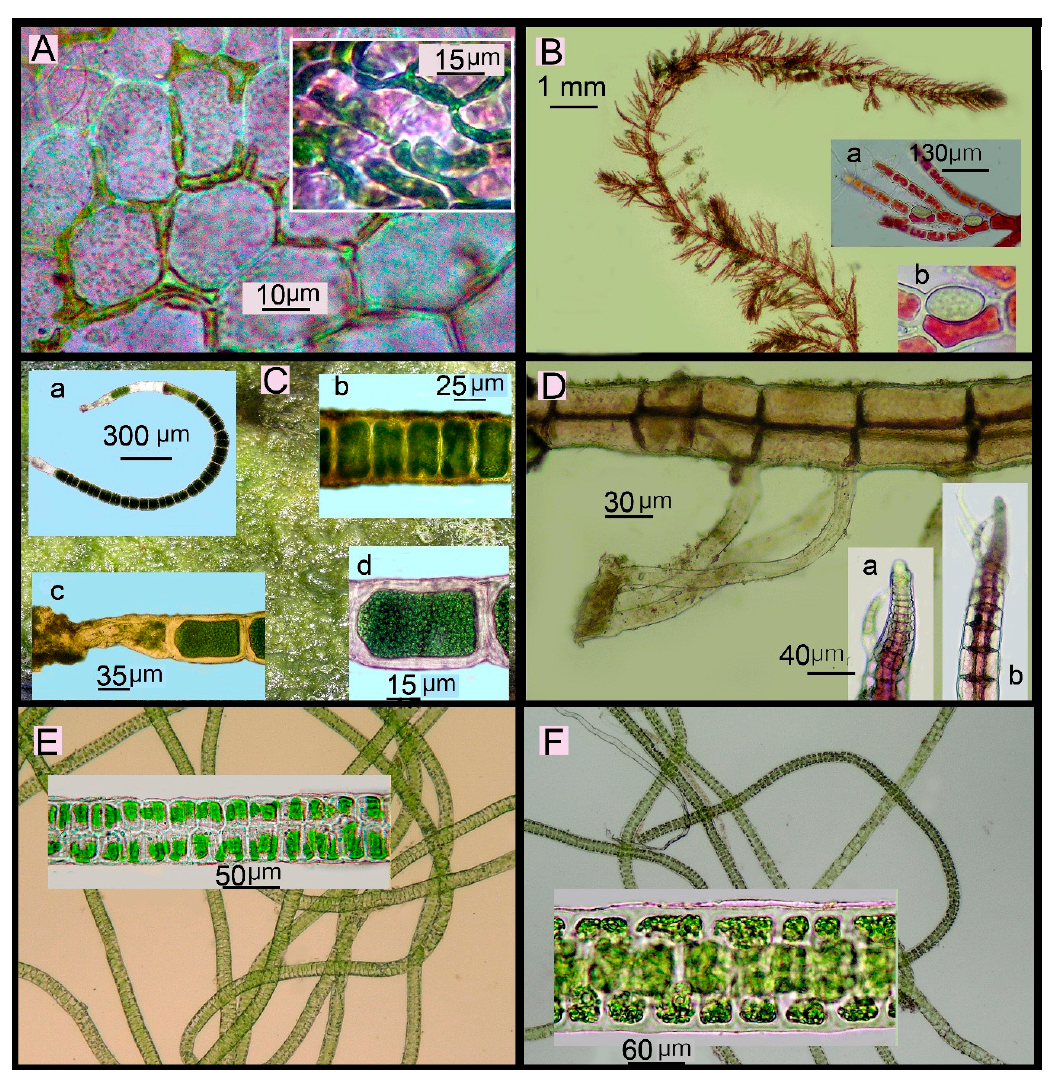
Figure 6. New records of benthic macroalgae for Japan found in Amakusa-Shimoshima Island. ( A ) Acrochaete geniculata (N.L. Gardner) O'Kelly, surface view showing cells arranged between outer cells of Hypnea sp. and Ceramium borneense (Inset). ( B ) Antithamnionella longicellulata Perestenko, habit. Insets: a, b, fragments showing ovoid gland cells. ( C ) Chaetomorpha javanica Kützing. Insets: a, habit; b, fragment showing dividing cells; d, fragment showing thick striated cell walls; d, basal part. ( D ) Melanothamnus pseudovillum (Hollenberg) Díaz-Tapia & Maggs, prostrate axis showing unicellular rhizoids proximal on pericentral cells. Insets: a, b, apex of erect axis. ( E ) Ulva chaetomorphoides (Börgesen) Hayden, Blomster, Maggs, P.C. Silva, M.J. Stanhope & J.R. Waaland, habit. Inset: fragment of filament in surface view. ( F ) Ulva ralfsii (Harvey) Le Jolis, habit. Inset: fragment of filament in surface